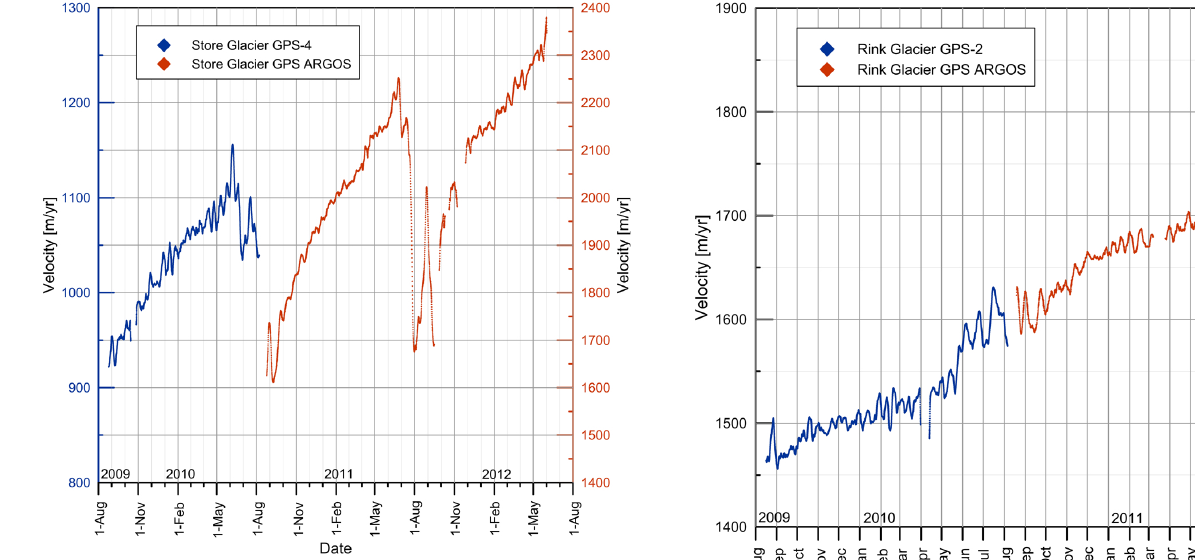
Figure 6. Store Glacier 7-day averaged GPS velocities (see Fig. 1 and Table 1 for instrument position and operational period). Note the di ff erent scales for the two GPS velocity records. Figure 7. Rink Glacier 7-day averaged GPS velocities (see Fig. 1